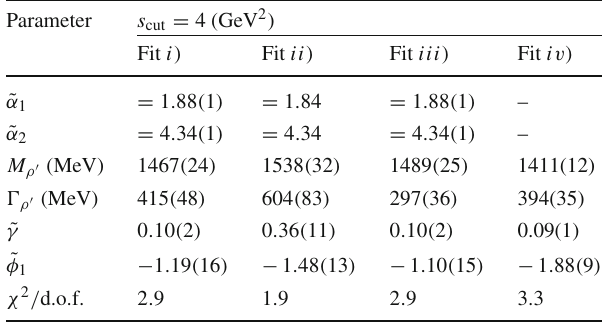
Table 7 Results for the fit to the BaBar τ − → K − K S ν τ data [16] with a three-times-subtracted dispersion relation including two vector ( s ) according to Eq.(53) with s resonances in F K V dispersive integral